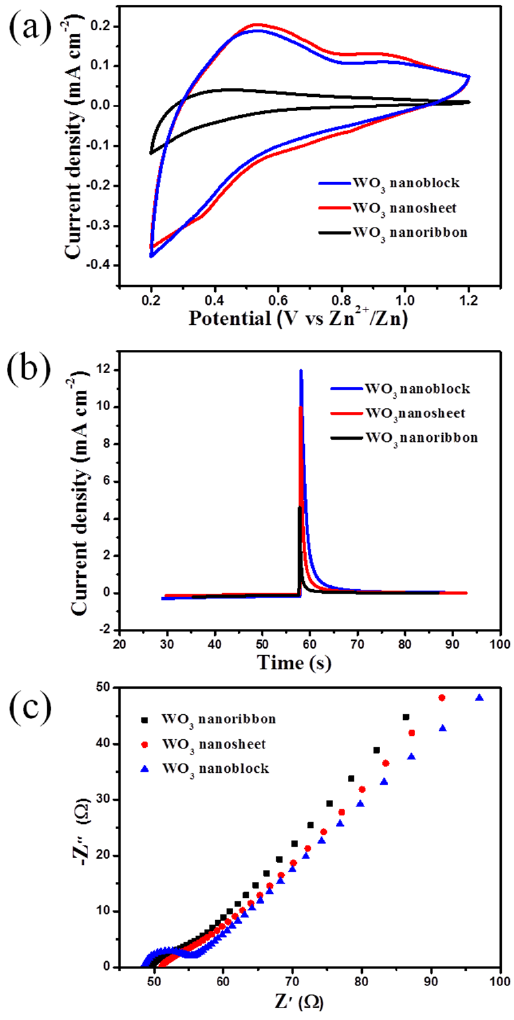
Figure 3. ( a ) CV curves, ( b ) Chronoamperometric curves, and ( c ) Nyquist plots of the WO 3 nanoblock, WO 3 nanosheet, and WO 3 nanoribbon array